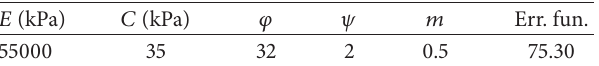
Table 9: The set of parameters obtained by direct method (experi- mental